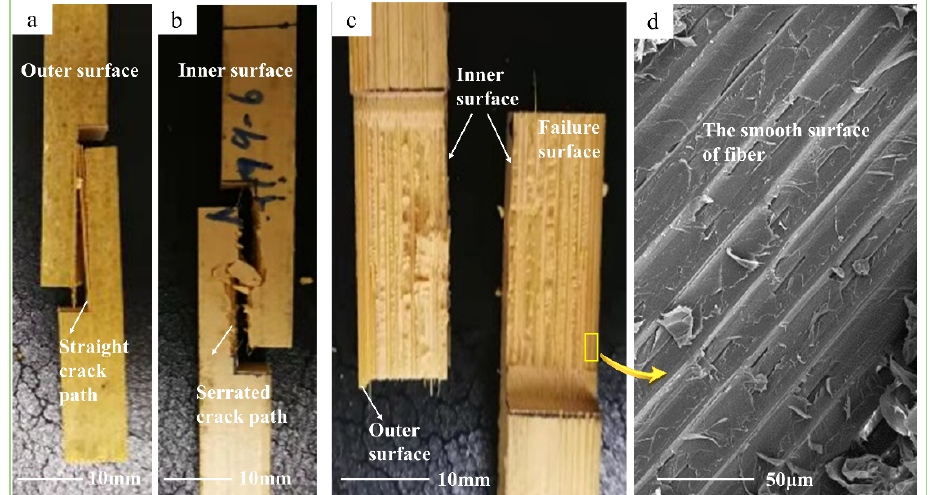
Figure 4. Shearing characteristics of tensile-shear method: ( a ) straight crack path at outer surface; ( b ) serrated crack path at inner surface; ( c ) shear-failure surface; ( d ) SEM image of smooth shear- failure surface.